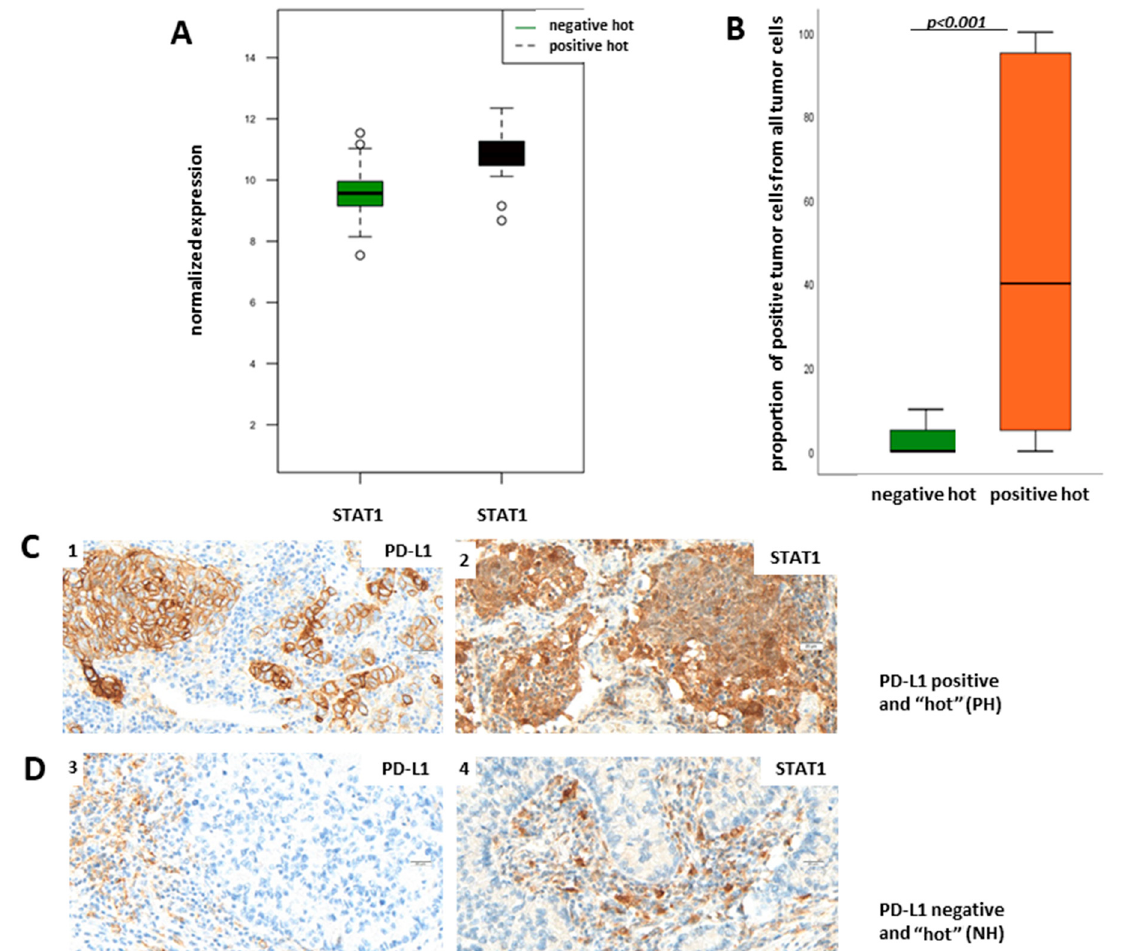
Figure 5. STAT1 is upregulated in PH LUADs. ( A ) Boxplot of transcriptomic analysis showing STAT upregulated in PH LUADs (black) when compared to NH LUADs (green). ( B ) STAT1 validation on the protein level. Boxplot of immunohistochemistry analysis showing STAT1 is more expressed in the PH group than in the NH group. STAT1 expression was quantified as the percentage of STAT1-positive tumor cells of all tumor cells. ( C ) Representative images of a PH LUAD (1) with STAT1 expression (2). ( D ) Representative images of a NH LUAD (3) without STAT1 expression (4) (objective magnification ×40; scale bar = 20 μ m).